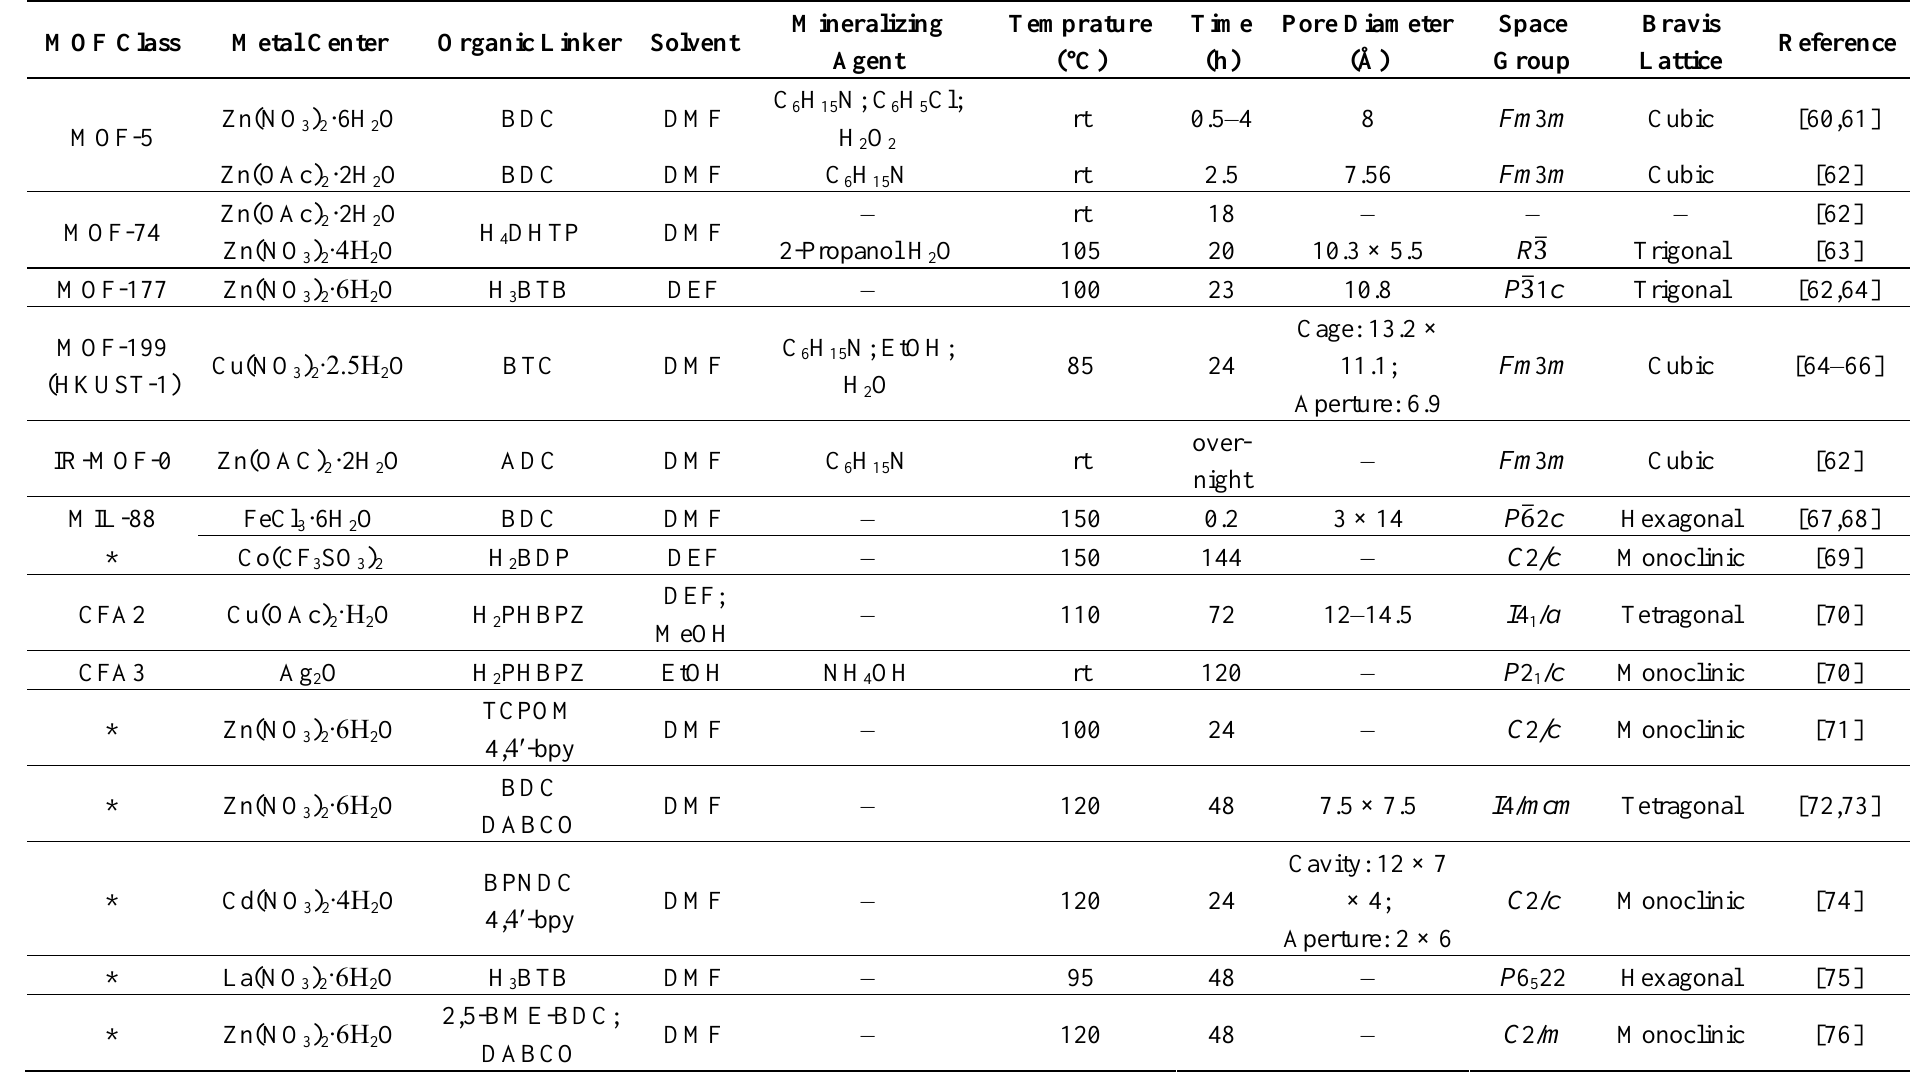
Table 2. MOFs Synthesized from Solvothermal